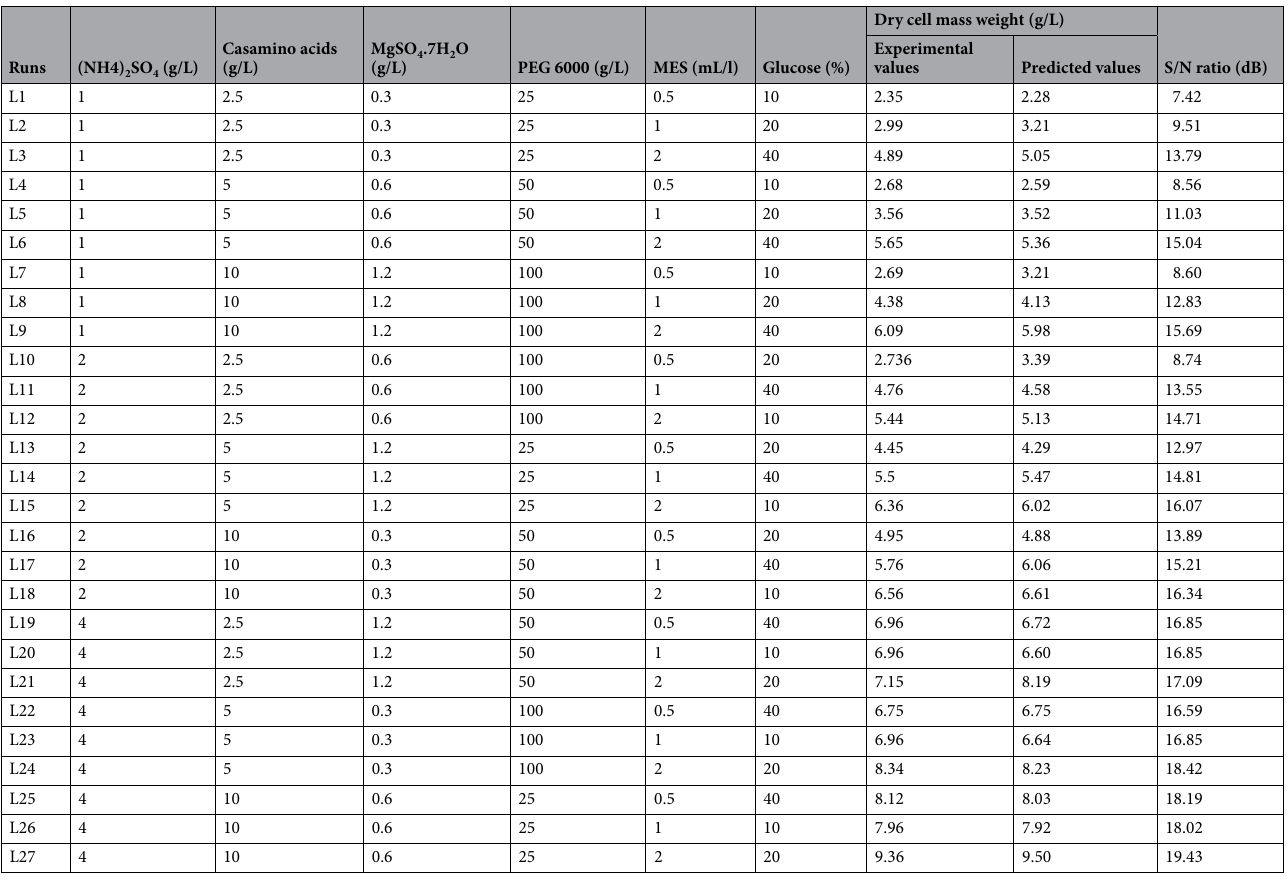
Table 1. Experimental setup for maximization the dry cell mass weight of strain E56 using Taguchi’s L 27 (3 6 ) orthogonal array design.